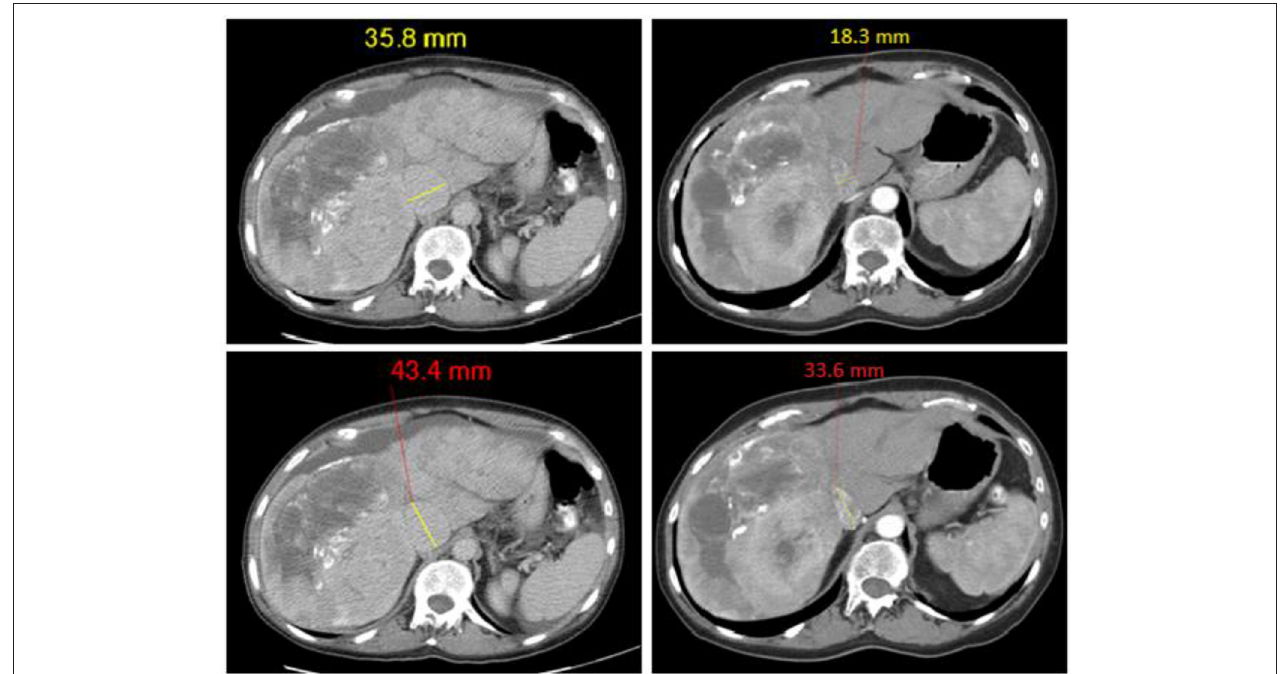
FIGURE 9 | Representative imaging for data in Figures 5 , 6 showing reduction in IVC diameters following tricuspid valve replacement; before surgery images on left hand side, after surgery images on right hand